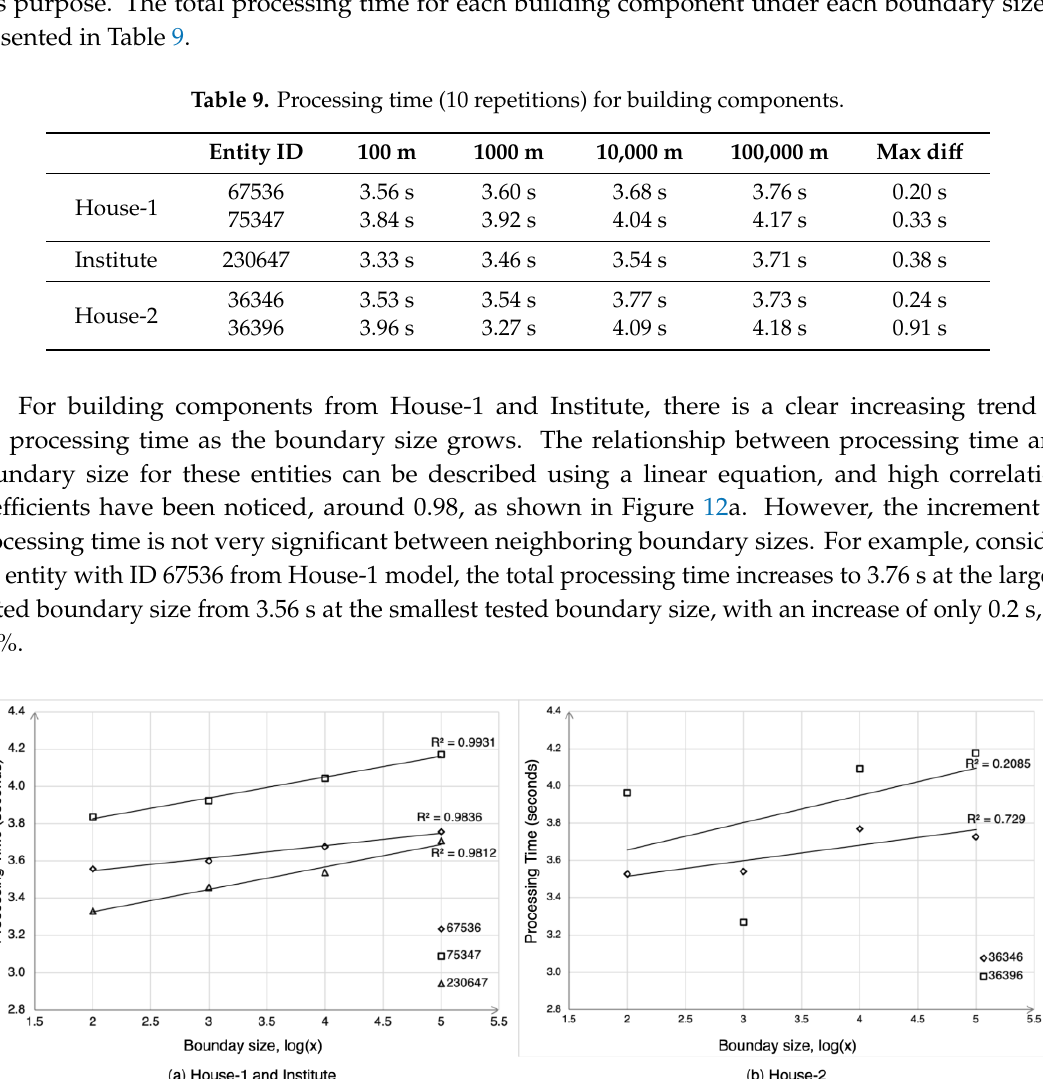
Table 9. Processing time (10 repetitions) for building components.